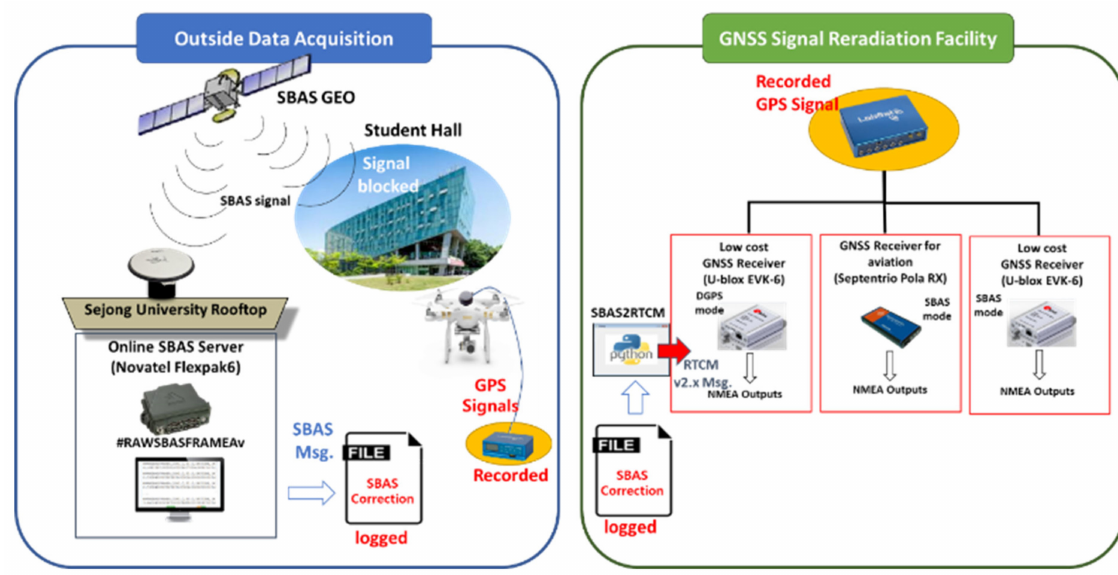
Figure 13. Field test replay set